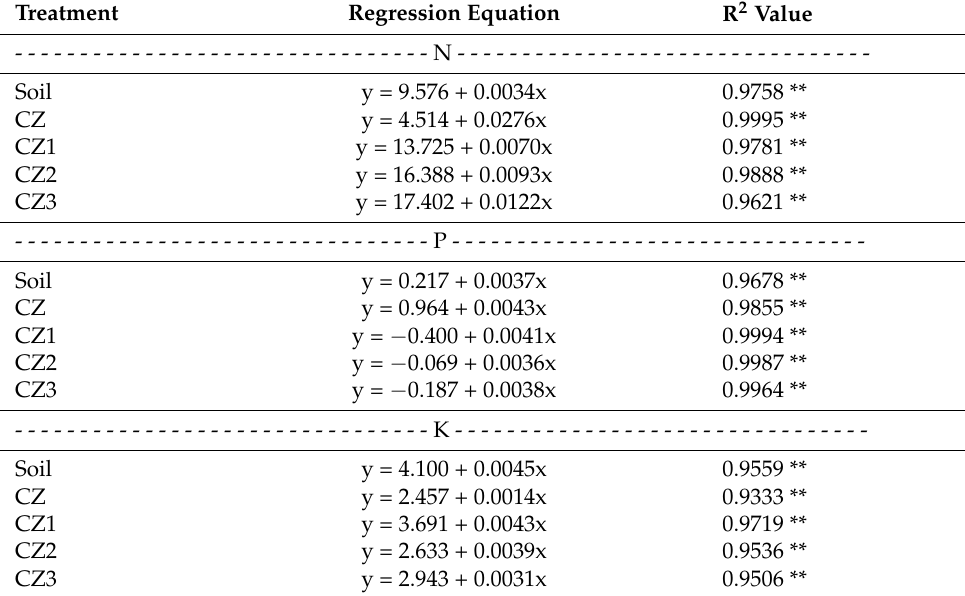
Table 21. Linear relationships between the added amounts nitrogen, phosphorus, and potassium and their amounts